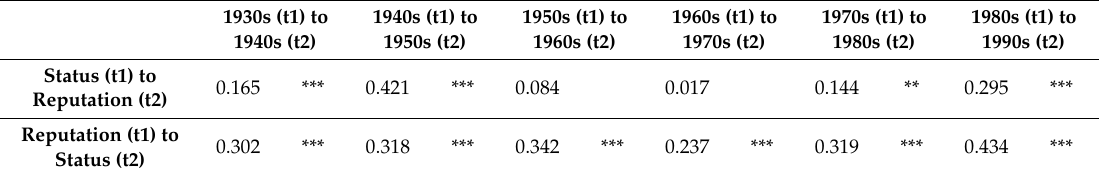
Table 2. Pearson’s r correlation coe ffi cients between artists’ reputation and status per decade.